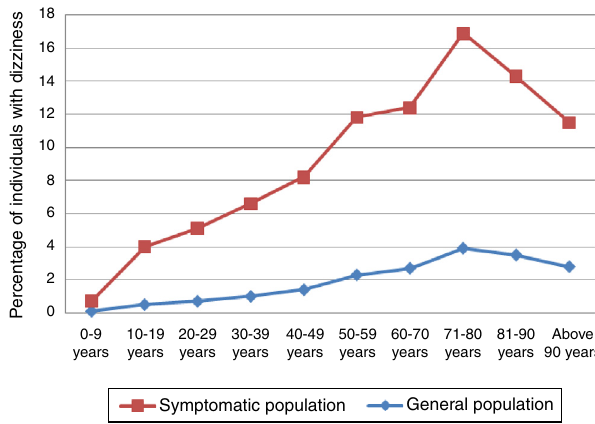
Prevalence of dizziness according to age. Source : Sample Survey of Households of Minas Gerais (PAD-MG). Fundac¸ão João Pinheiro,